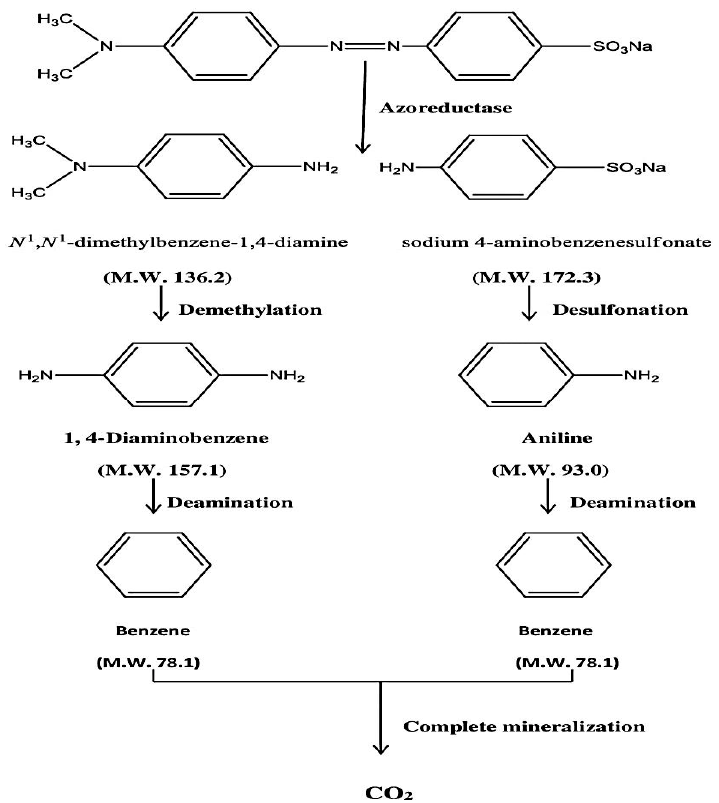
Scheme 1. The proposed mechanism of degradation through which Pseudomonas